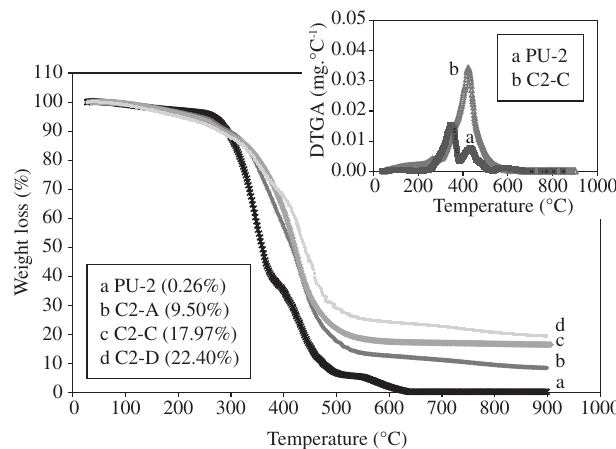
Figure 8. Dependence of the 1040/1180 cm -1 absorption band ratio on the inorganic content of C1 and C2 modified polyurethanes.